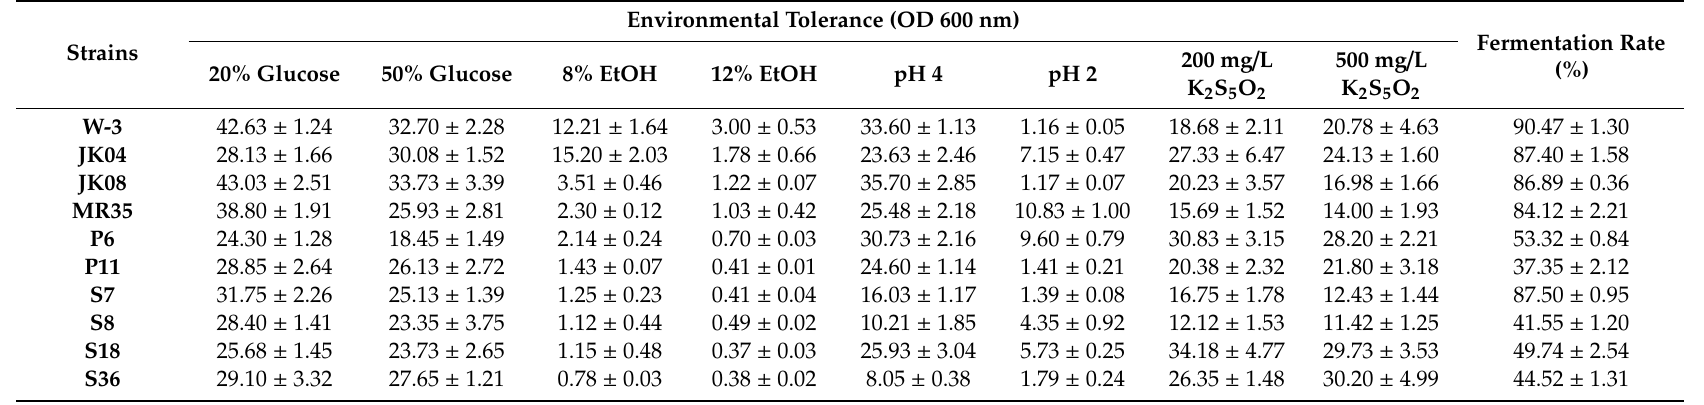
Table 3. Tolerance to various environmental stressors and fermentation rates of Saccharomyces cerevisiae W-3 and nine non- Saccharomyces yeasts.